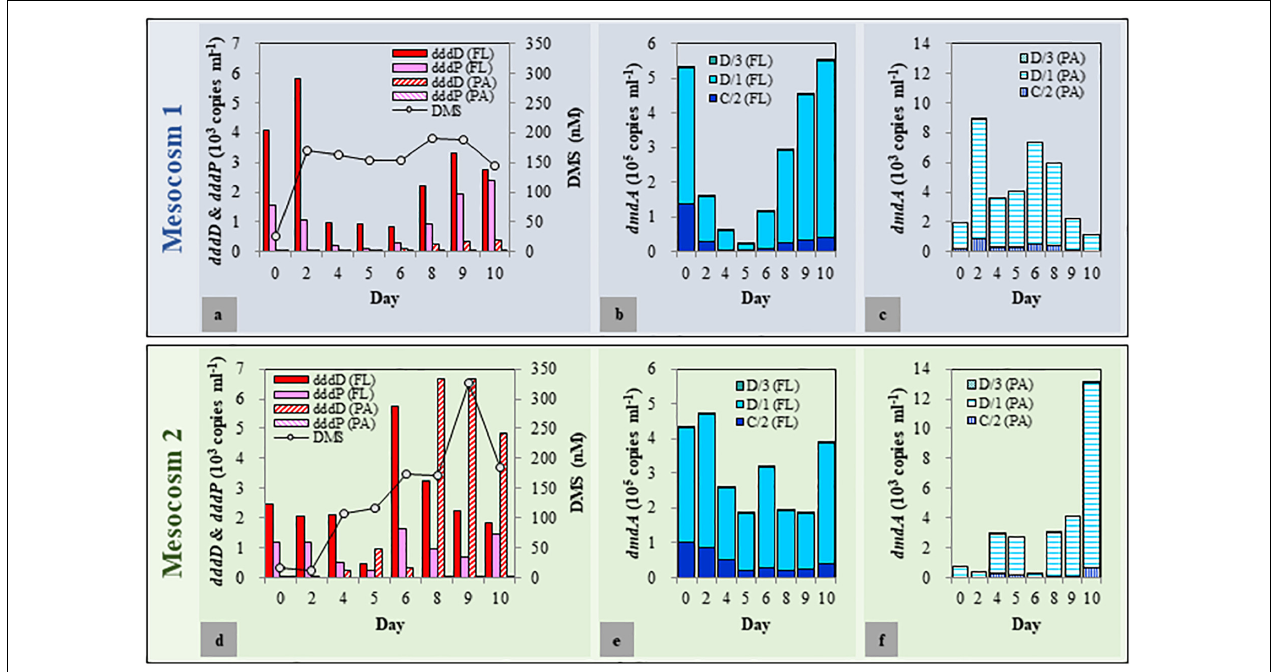
FIGURE 3 | Abundance of dimethylsulfoniopropionate (DMSP) degradation genes in free-living (FL) and particle-associated (PA) fractions and changes in the dimethyl sulfide (DMS) concentrations during the mesocosm experiment. (a–c) Mesocosm 1; (d–f) : Mesocosm 2.